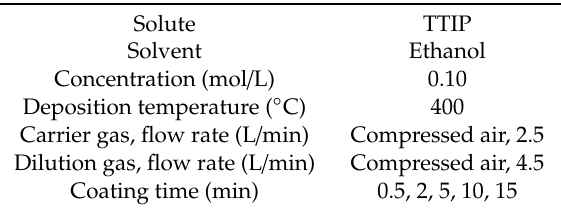
Table 3. Deposition conditions of TiO 2